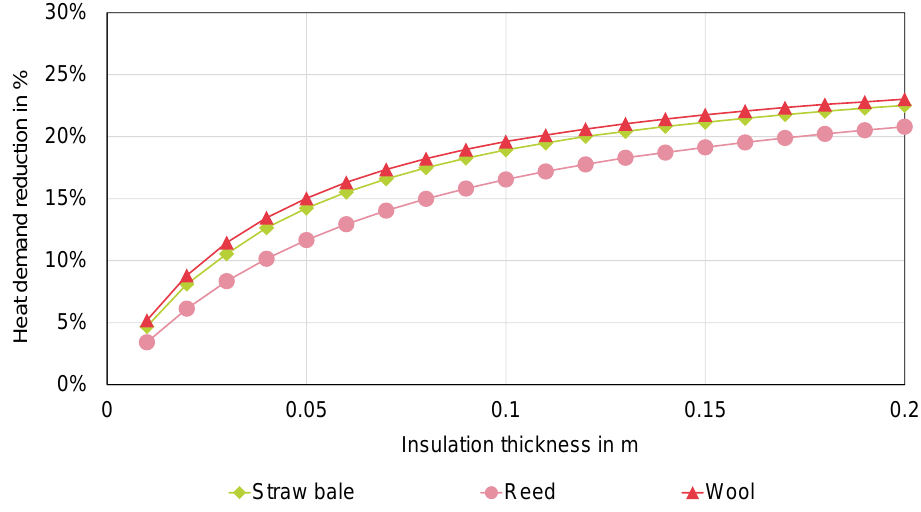
Figure 21. Wall insulation with locally available insulation materials with varying thicknesses of the insulation layer presents the potential of natural insulation materials in rural Kyrgyzstan.